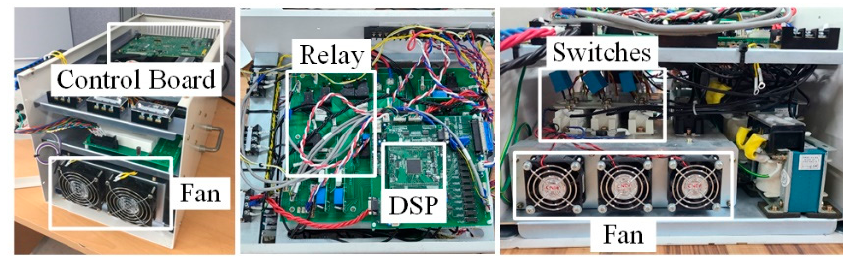
( b ) Figure 12. Simulation results of output voltage control of integrated OBC when the load impedance is abruptly changed ( a ) without a feedforward component of output power and ( b ) with a feedforward component of output power. 5. Experimental Results